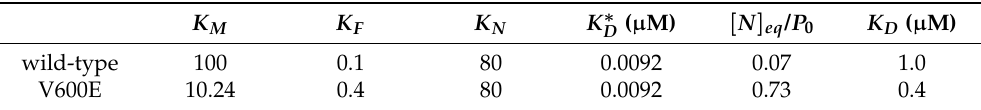
Table 2. A hypothetical set of equilibrium constants that are consistent with the measured Cdc37 affinities of the wild-type B-raf and the V600E mutant. The dissociation constants are similar between the inactive wild-type and the active